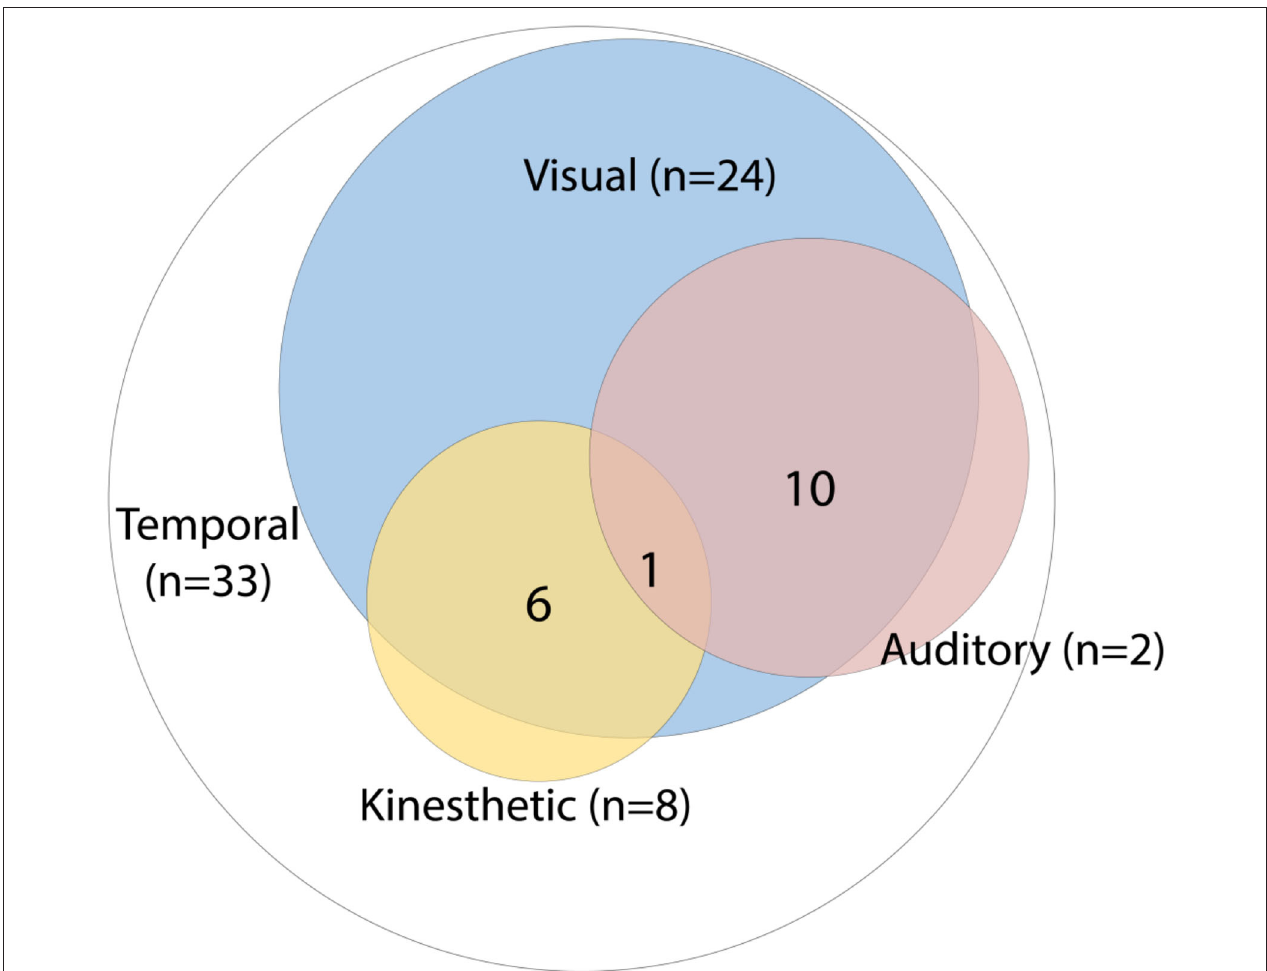
FIGURE 2 | Distribution of sensory modalities involved in time distortions ( N =